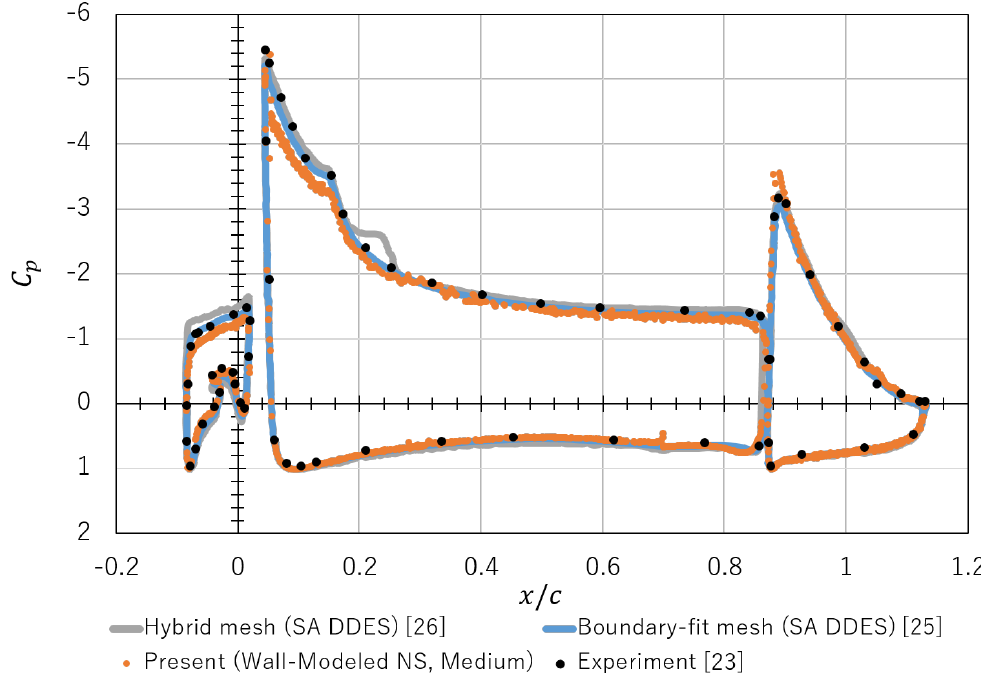
Figure 11. Surface pressure distribution of the 30P30N high-lift airfoil configuration when θ = 5.5 ◦ ; SA DDES, detached eddy simulation with Spalart–Allmaras turbulence